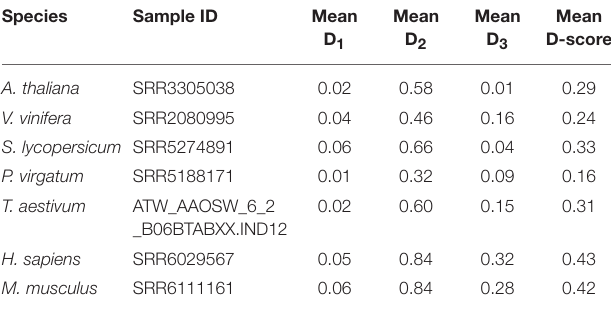
TABLE 3 | GeneQC analysis of seven